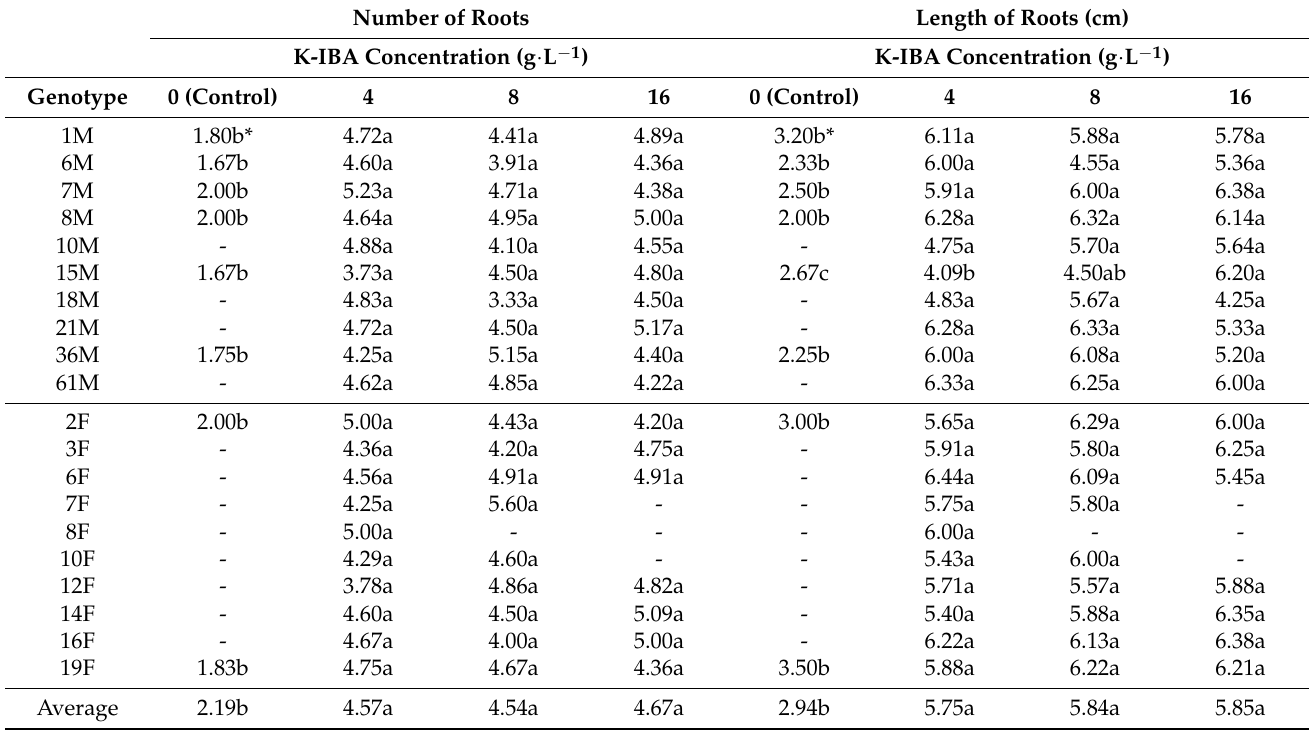
Table 3. Effect of different concentrations of K-IBA on the root number and length (cm) of the 20 genotypes of P. lentiscus var. Chia shoot cuttings rooted in